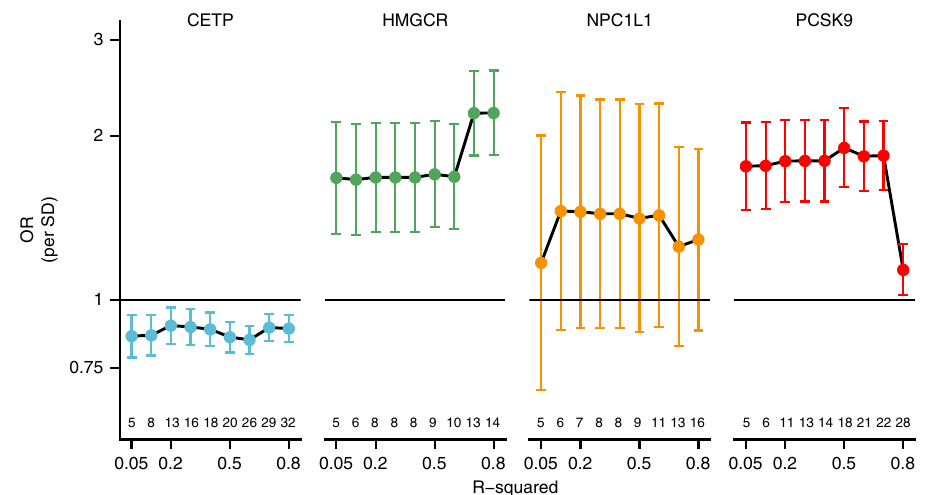
Fig. 3 Mendelian randomisation estimates of the lipids weighted associations with CHD under increasingly liberal LD-clumping thresholds. Lipids data were used from the GLGC, and linked to coronary heart disease data from CardiogramPlusC4D. Pairwise LD remaining after LD-clumping was accounted for using the 1000 genomes ‘ EUR ’ reference panel 52 and a generalised least squares method 17 . Estimates for PCSK9, HMGCR , and NPC1L1 are given per SD in LDL-C, CETP estimates per HDL-C re fl ecting the likely effectiveness pathway to CHD. The number of included variants is depicted above the x-axis. Estimates are given as OR with 95%CI (vertical error bars).